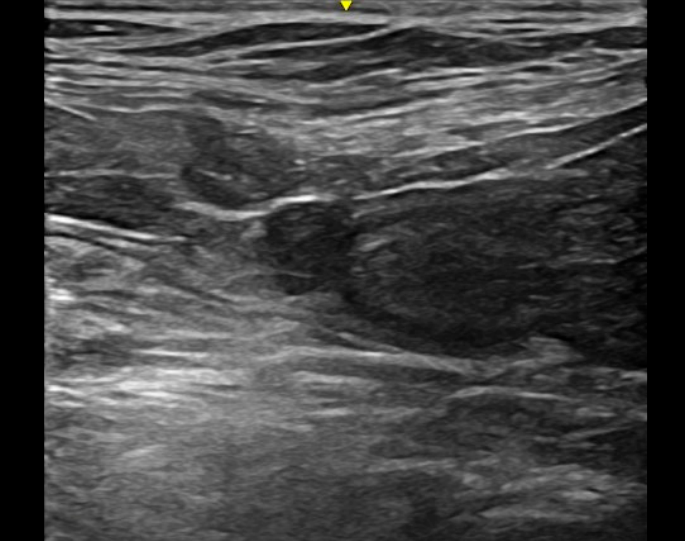
Figure 4. Longitudinal ultrasound image of the cranioventral part of the urinary bladder in a cat, showing the presence of a small ( < 1 cm diameter), well-defined, round, thin-walled, anechoic formation, cranial to the bladder apex, consistent with urachal cyst. The urinary bladder is empty. Patent urachus was present in only one mixed-breed dog of 6 months of age. The urachal presented a tubular structure and anechoic content. The formation began from the bladder and ended at the umbilicus (Figure